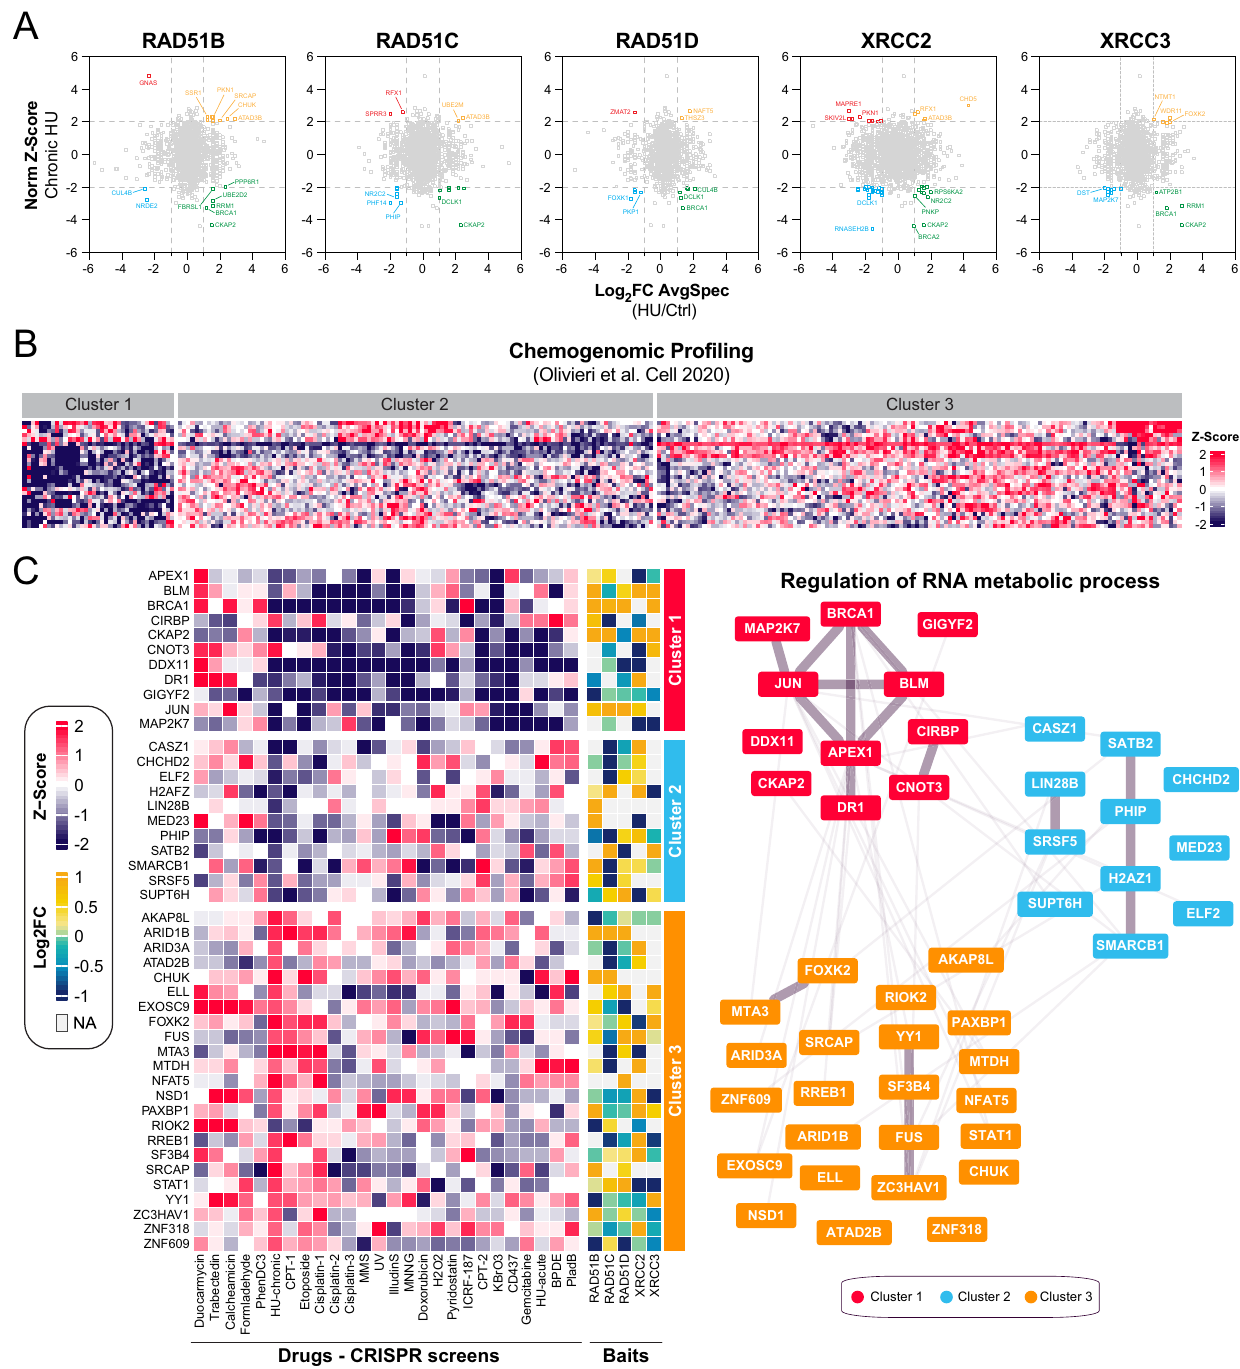
Fig 4. RNA metabolic process collaborates with the RAD51 paralogs upon replication stress. (A) Differential BioID analysis of the classical RAD51 paralogs upon HU exposure intersected with a CRISPR-based genome screen where sensitivity to a chronic HU treatment was tested [23]. Data are represented as the log 2 FoldChange (log 2 FC) of the average peptide count for a given prey between HU and untreated conditions on the x-axis and the NormZ-score for the HU- chronic CRISPR screen published in [23]. Significant differentially modulated proximal interactors are considered for those with log 2 FC < 1 or > 1 and NormZ- score < -2 or > 2. (B) Heatmap clustering representing the NormZ-scores of the preys significantly modulated identified in (A) and monitored in a series of CRISPR screens published by [23] where drugs inducing replication stress were tested in RPE1-hTERT cells. (C) Representation of the different factors involved in RNA metabolic process and identified in each